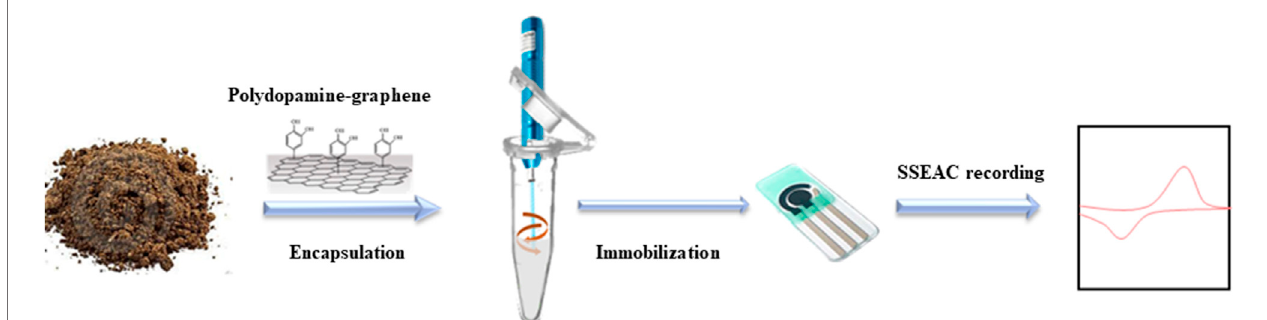
FIGURE 1 | Schematic process of proposed electrochemical method for soil particle encapsulation.